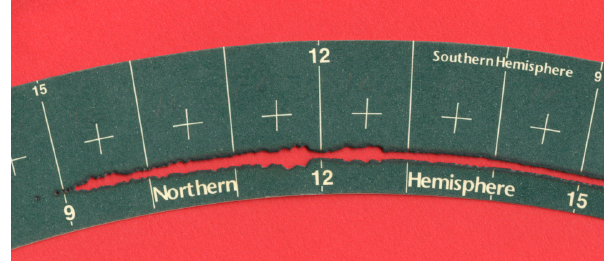
Fig. 1. Excerpt from a scan image of a sunshine recorder card that illustrates how the amount of card burn can vary in width (across track). The maximum width of burn in this image exceeds 5mm. This card is from Lerwick for 3 June 2006.